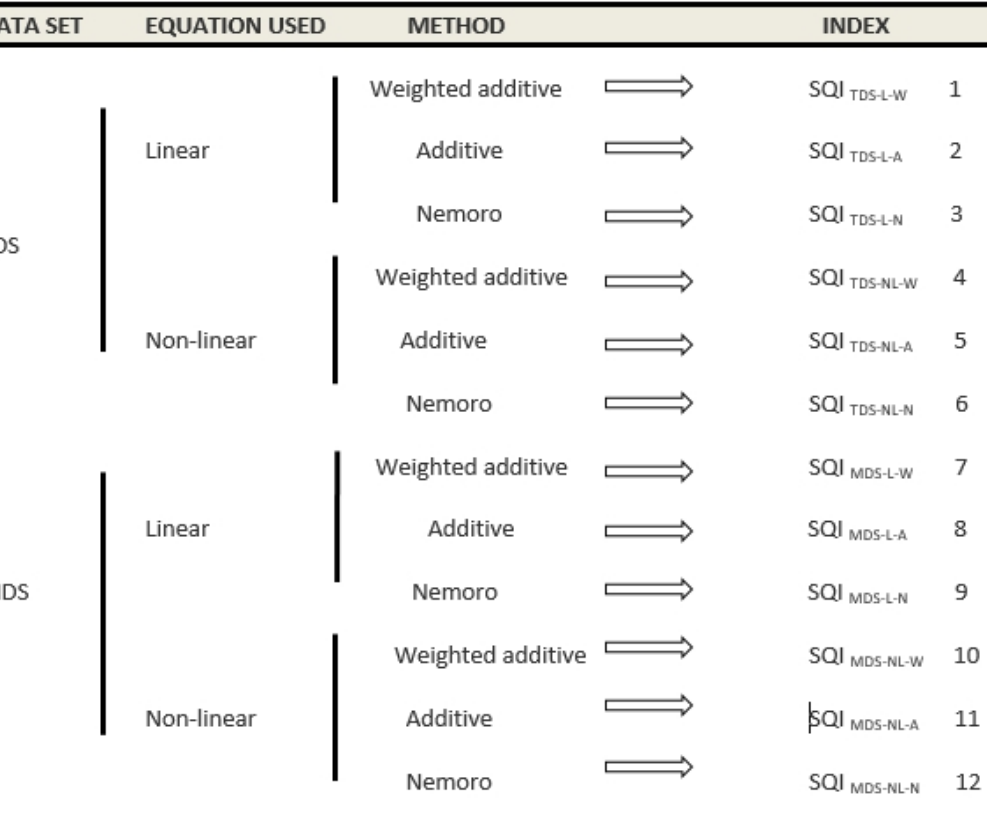
Figure 4. The twelve soil quality indices calculated in this study.